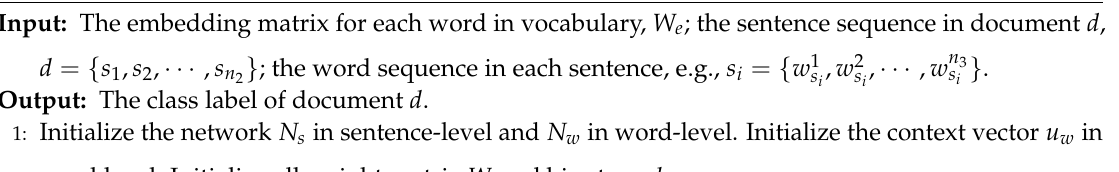
Algorithm A1 Self-interaction attention mechanism for document